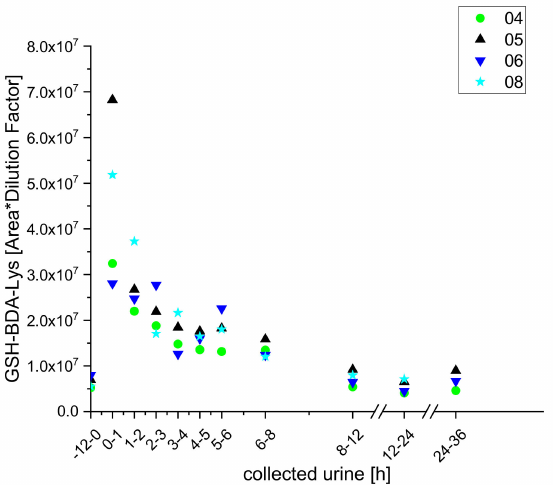
Figure 5. Excretion kinetics of GSH-BDA-Lys: UPLC-qToF-MS / MS measurements of contents in samples of urine from participants four, five, six, and eight at indicated times after co ff ee consumption (h). Using UPLC-qToF-MS / MS, we also identified furan metabolites in the urine of the participants that had previously only been detected in vitro or in the bile of rats [19]. These included the GSH adducts glutathione butendial acetyl lysine (GSH-BDA-AcLys), glutathione butendial glutamic acid (GSH-BDA-Glu) cysteine butendial glutathione (Cys-BDA-GSH), and cysteine glycine butendial glutathione (Cys-Gly-BDA-GSH). All of these were identified, by exact masses and MS 2